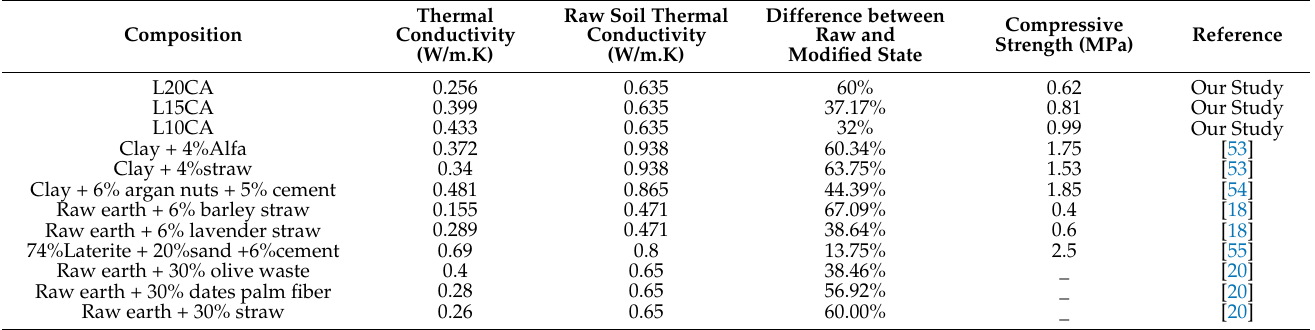
Table 4. Thermal conductivity/compressive strength of our bricks compared to the ones insulating materials presented in the